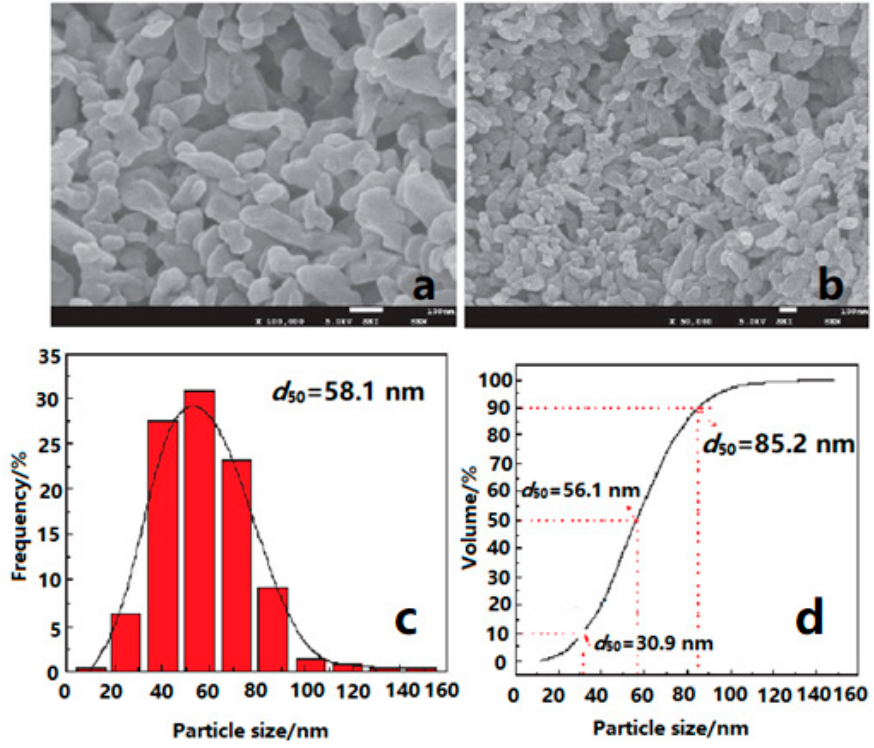
Figure 3. SEM images and particle size distribution of nTATB. ( a ) nTATB, ×100,000; ( b ) nTATB, ×50,000; ( c ) Frequency distribution; ( d ) Cumulative distribution. Reproduced from [38], with permission from Journal of Solid Rocket Technology (Gu Ti Huo Jian Ji Shu), 2017.